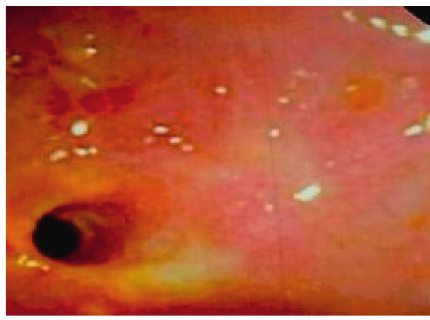
Figure 10: Fistulous tract opening in the lumen.